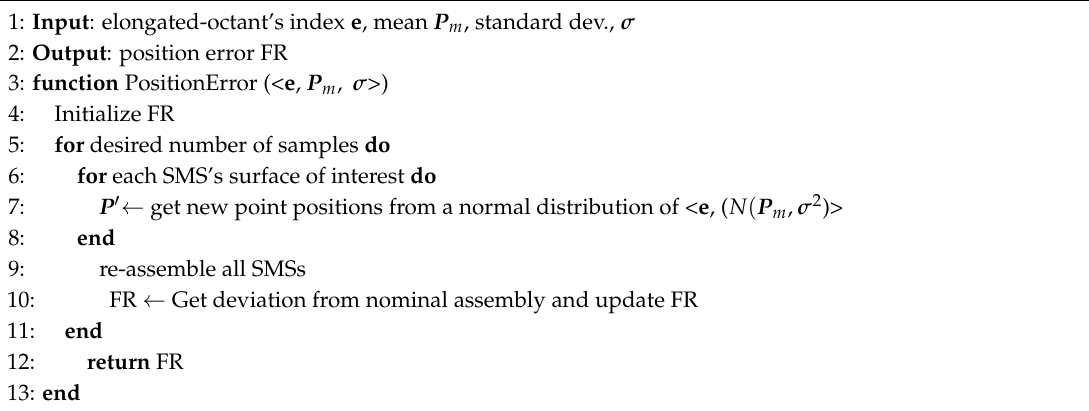
Algorithm 2. Pseudocode for implementing Octree-based statistical tolerance